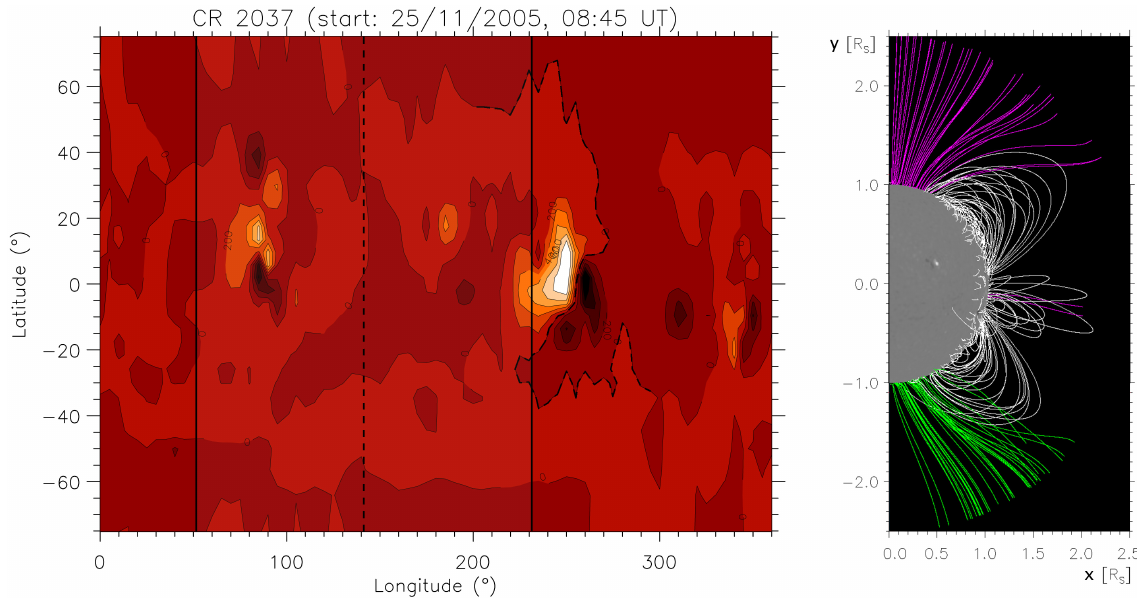
Fig. 2. Left: A map of photospheric magnetic fields observed during the transit of the AR complex across the solar disk (Carrington Rotation 2037); colors range from − 10 3 G (black) up to +10 3 G (white). This map has been obtained by averaging the original magnetic field measurements by SOHO/MDI instrument, in order to reduce the complexity around the CME source region. Vertical solid lines delimit the solar hemisphere visible on 11 December 2005, while the dashed curved line shows the position of the neutral line across the West solar limb. Right: the pre-eruption coronal magnetic field configuration as extrapolated (with a Potential Field Source Surface approximation) above the West